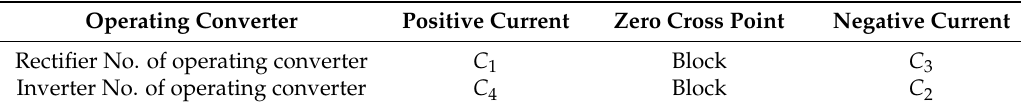
Table 1. Mode operation of the cycloconverter.